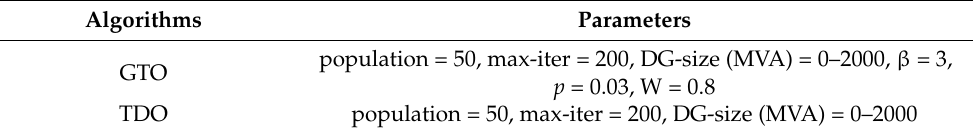
Table 3. Control parameter settings.